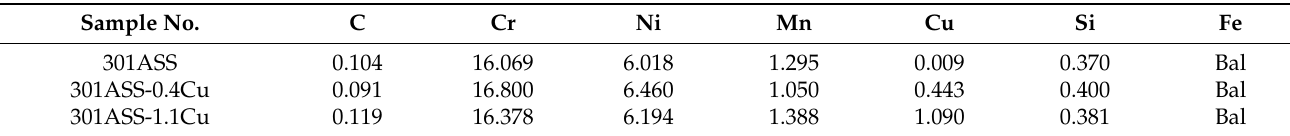
Table 1. Chemical composition of test 301 stainless steels/(wt.%). Sample